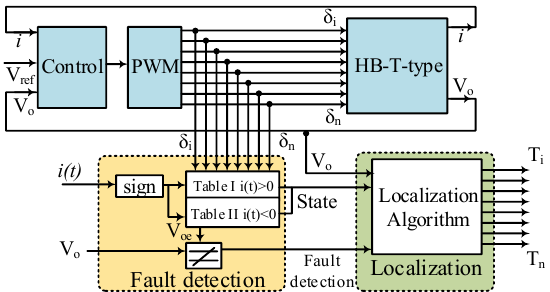
Fig. 3 Fault diagnosis principle for a T-type converter